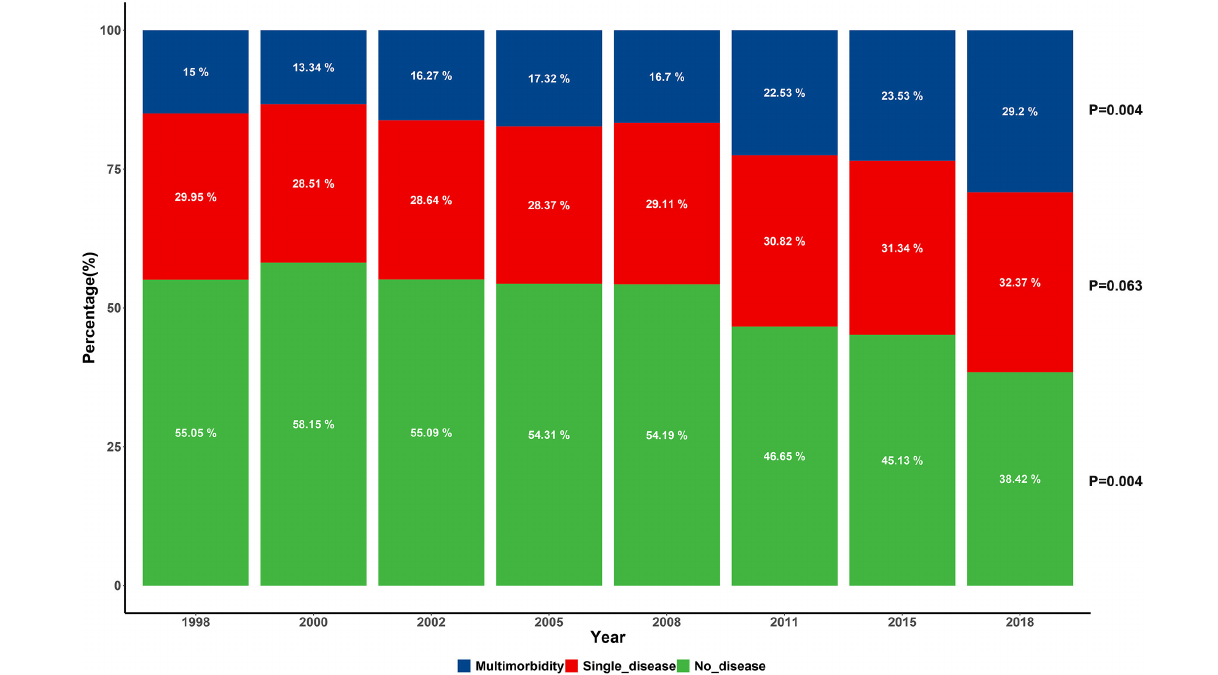
Frontiers in Medicine |